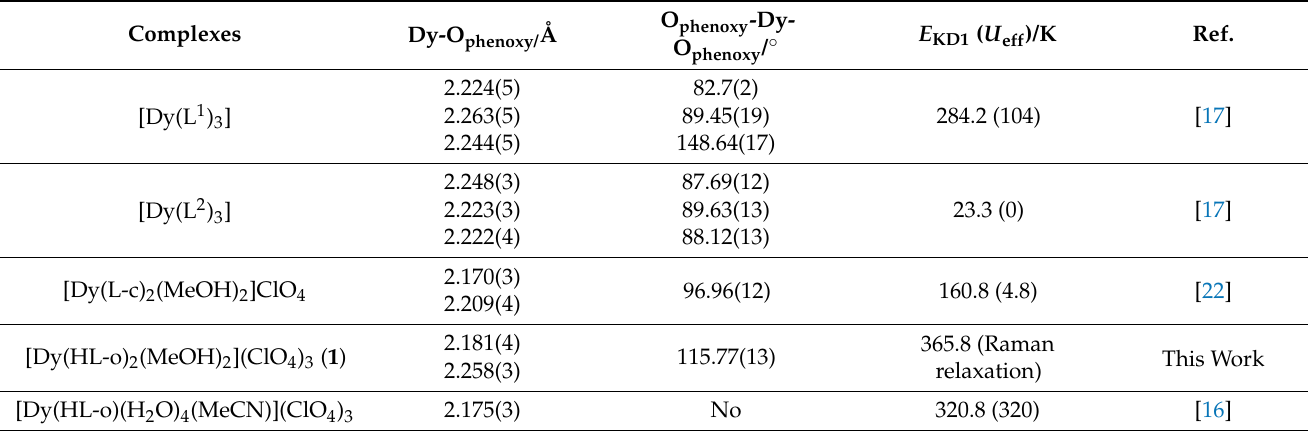
Table 3. Comparison of structure and magnetic properties for the Dy(III) salicyldehyde-rhodamine complexes. Complexes